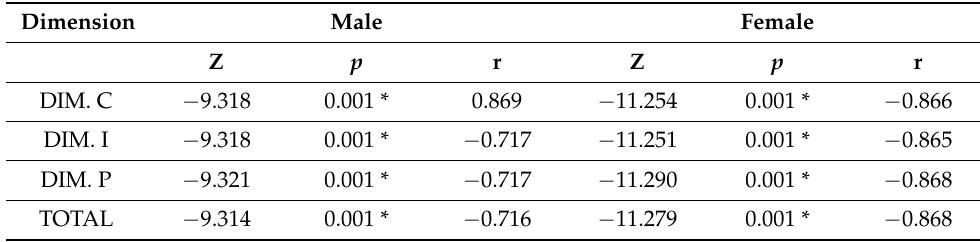
Table 4. Wilcoxon test between pre-test and post-test